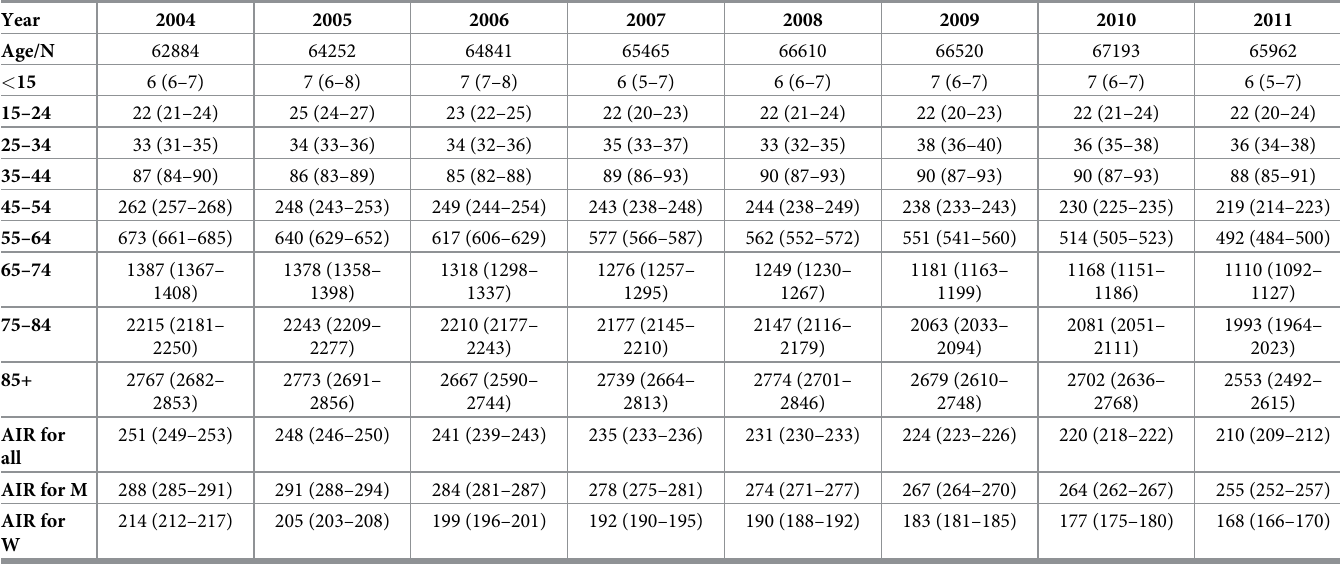
Table 1. Age and sex-specific adjusted incidence of all first-ever strokes (per 100,000 person-years) in Chinese populations in